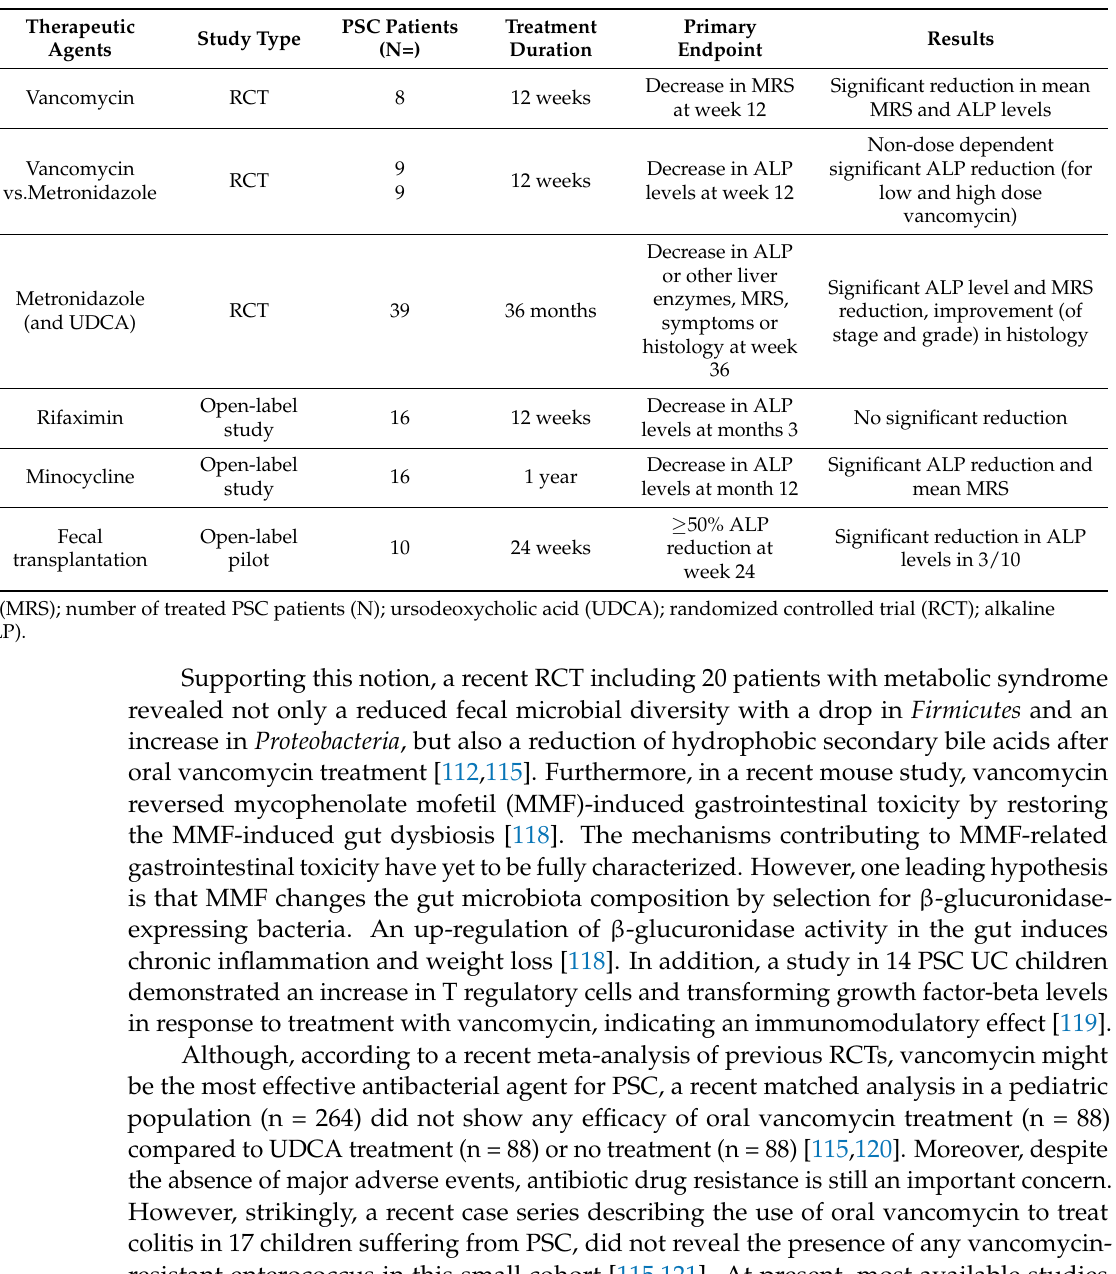
Table 2. Overview of therapeutic agents targeting gut microbiota and their study